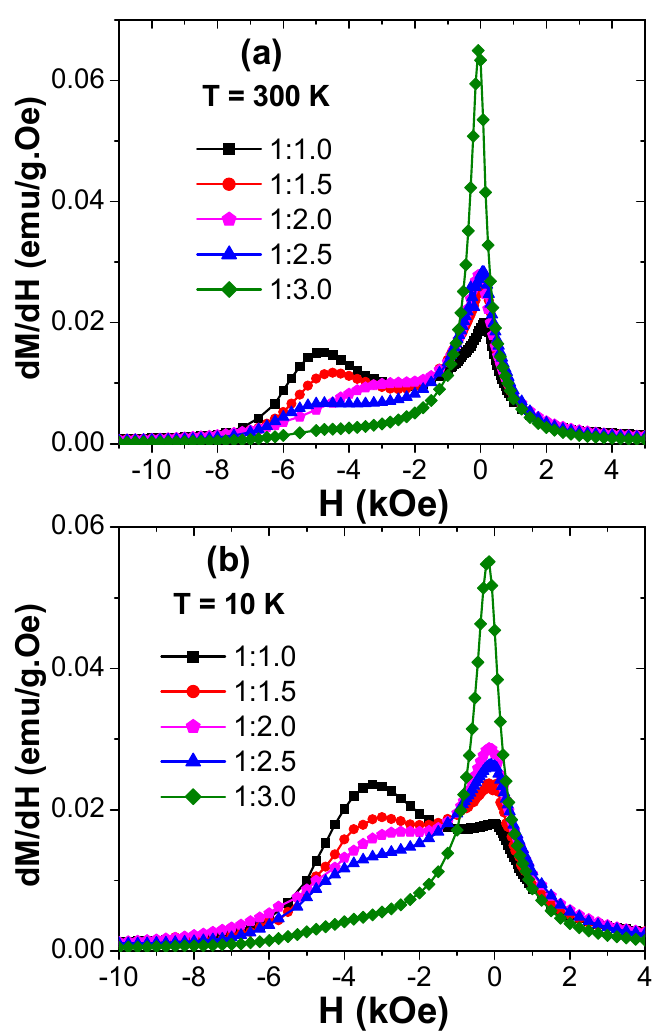
Figure 9. dM / dH vs. H plots performed at ( a ) T = 300 K and ( b ) T = 10 K for various prepared hard / soft ferrite SrBaSmFe / (NiZnFe) x NCs (0 ≤ x ≤ 3) products.